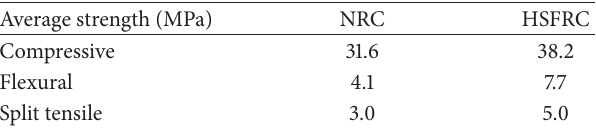
Table 1: Mechanical properties of NRC and HSFRC.